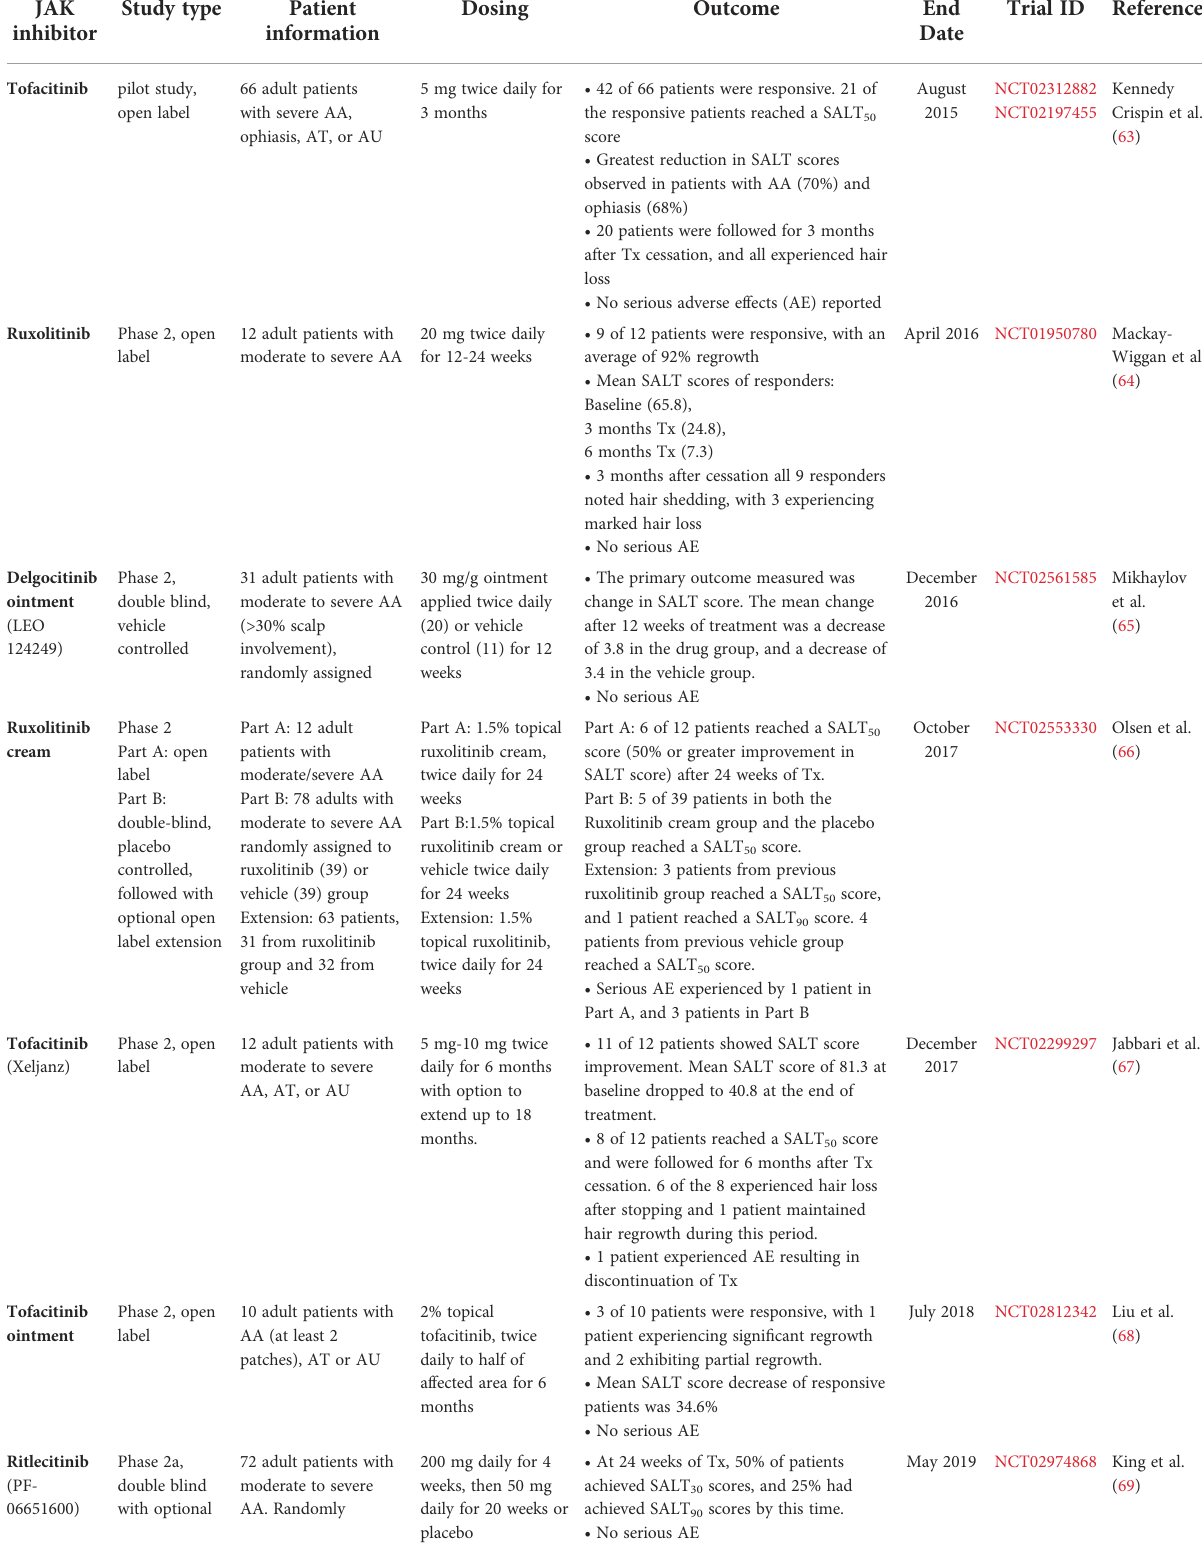
TABLE 2 Completed or currently active clinical trials involving the use of JAK inhibitors to treat